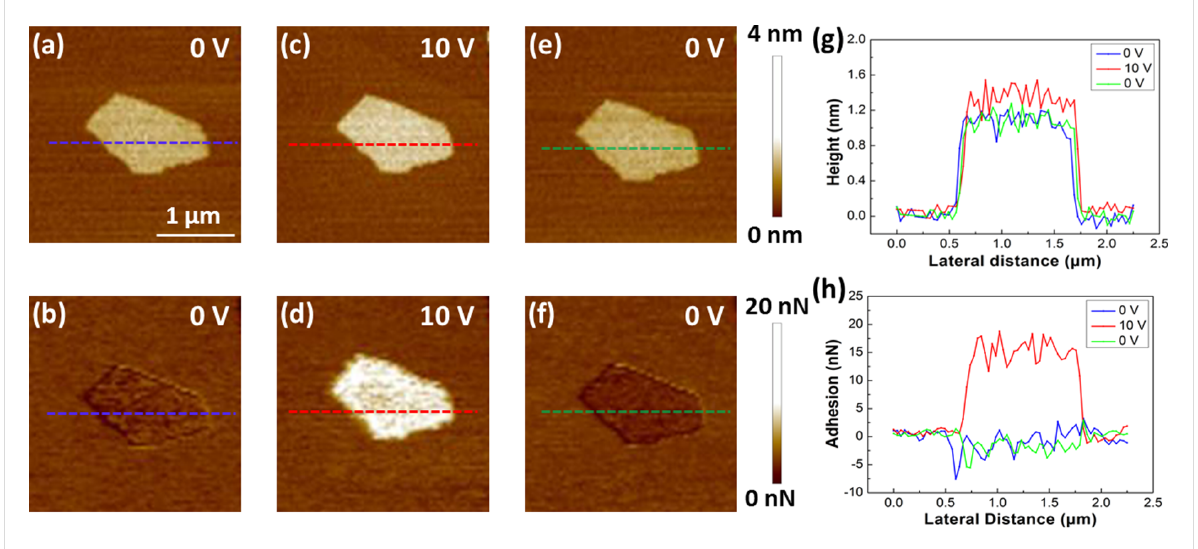
Figure 2: AFM height and adhesion images of single-layered CRGO sheets under different tip biases obtained in PF-QNM mode. (a,c,e) Height images obtained with an AFM tip biased at 0 V, 10 V, and 0 V, respectively. (b,d,f) Adhesion images corresponding to (a), (c), and (e), respectively. All of the images were taken with a peakforce set point of 5 nN. (g) Cross-sectional profiles along the blue, red, and green dashed lines in (a), (c), and (e), respectively. (h) Cross sectional profiles of the blue, red, and green lines in (b), (d), and (f),